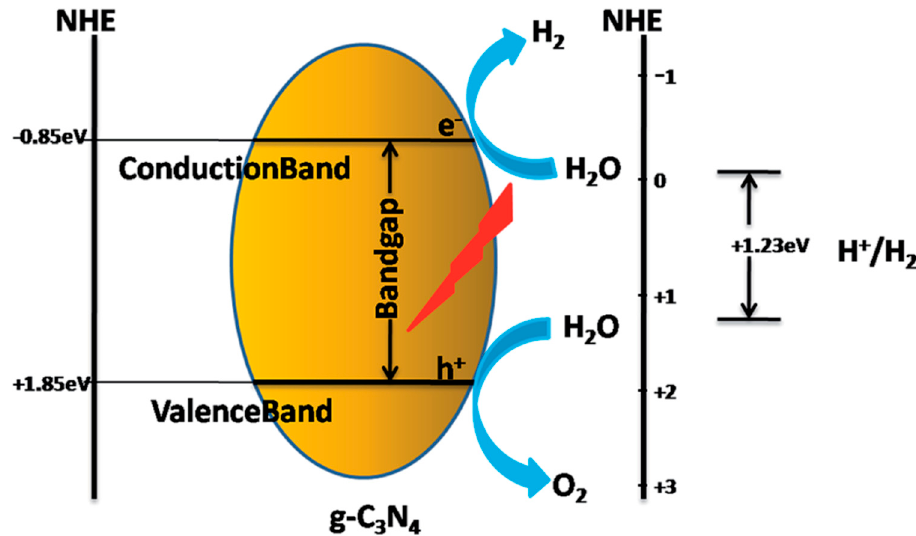
Figure 3. Schematic illustration of the charge-transfer mechanism of neat g-C 3 N 4 as a photocatalyst. Reproduced with permission from [48]; copyright (2016), Royal Society of Chemistry Advances.